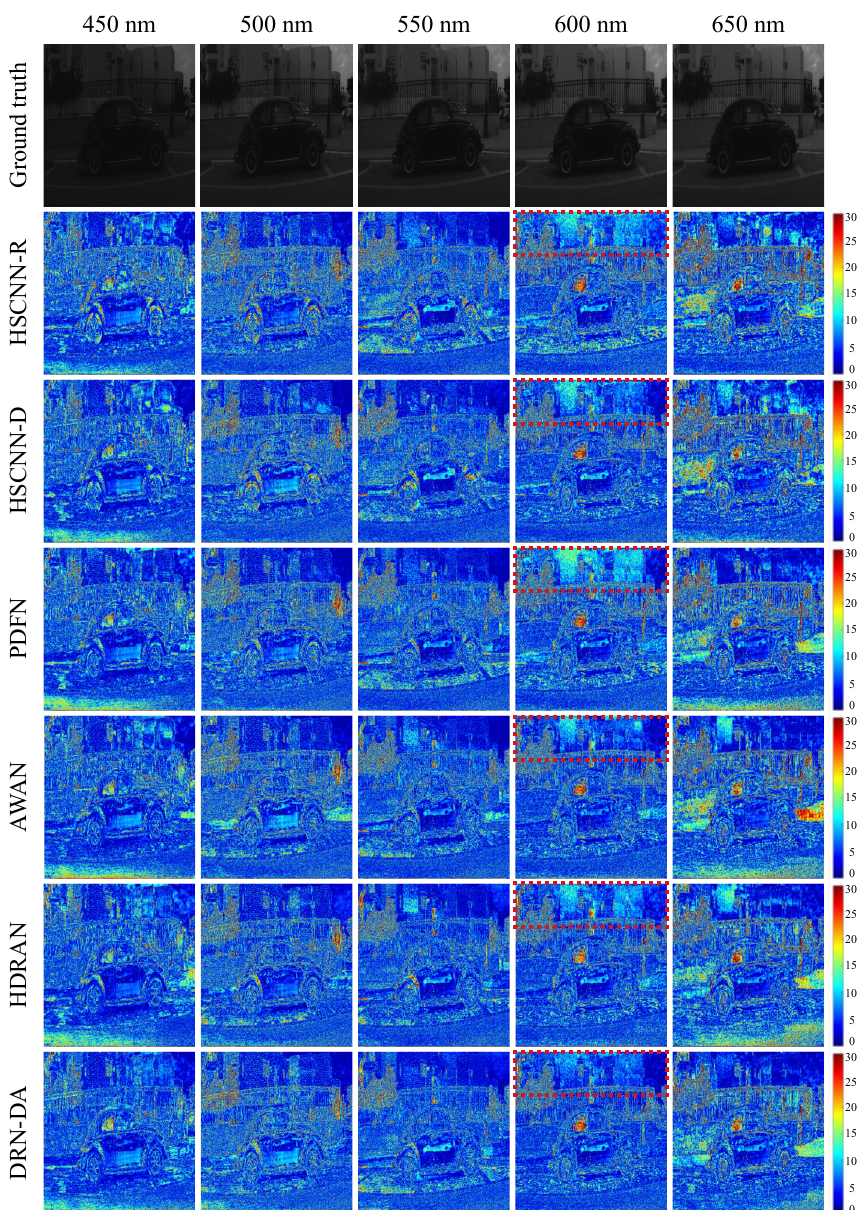
Figure 7. Visual hyperspectral reconstruction results and visual comparisons of five selected bands for hyperspectral reconstruction error maps from one NTIRE 2018 “Real World” RGB image. The significant differences are shown in the red frames. Please zoom in for better